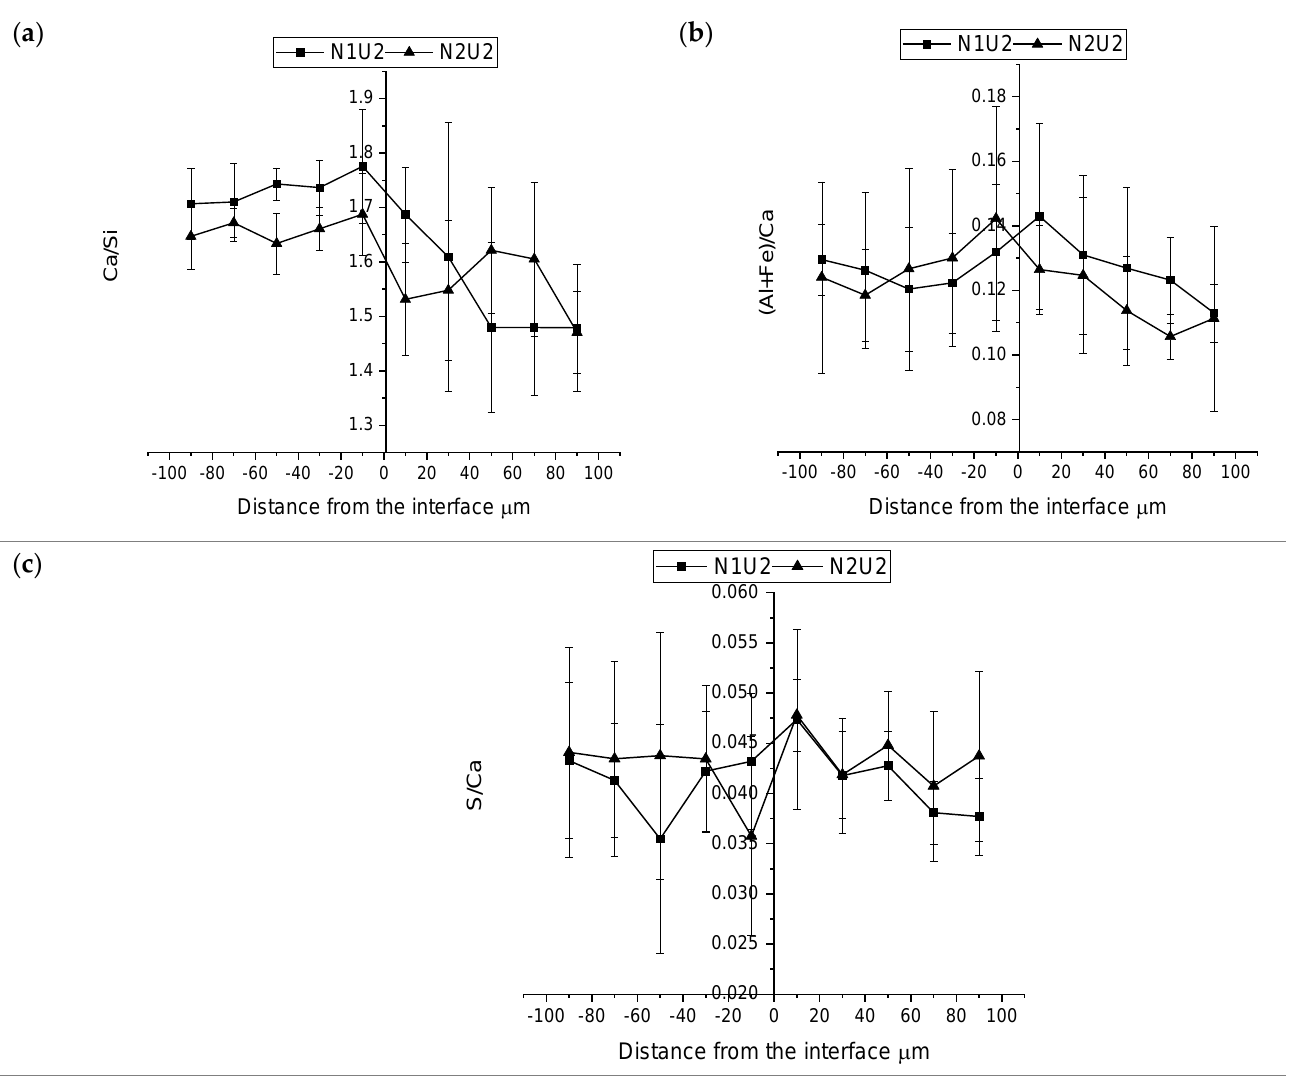
Figure 10 . Average atomic ratio and its corresponding standard deviation of hybrid concrete (U2N1, U2N2) ( a ) Ca/Si, ( b ) (Al+Fe)/Ca, ( c ) S/Ca . concretes (N1 and N2) in comparison with the UHPC mixes (U1 and U2) when measured